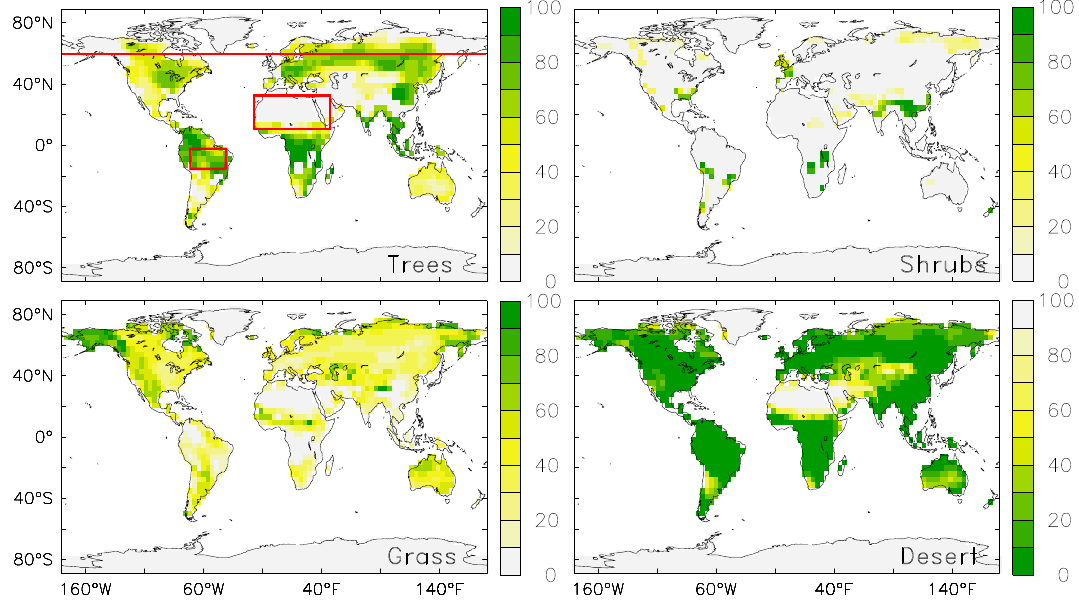
Fig. 1. Equilibrium vegetation distribution in the CTL simulation in [%], averaged over 50yr. Trees include tropical evergreen and deciduous forest as well as extra-tropical evergreen and deciduous forest. Grass comprises C3 grass and C4 grass, while shrubs include rain green and cold shrubs. Bare areas are interpreted as desert. The marked regions are chosen for detailed analyses of vegetation and climate